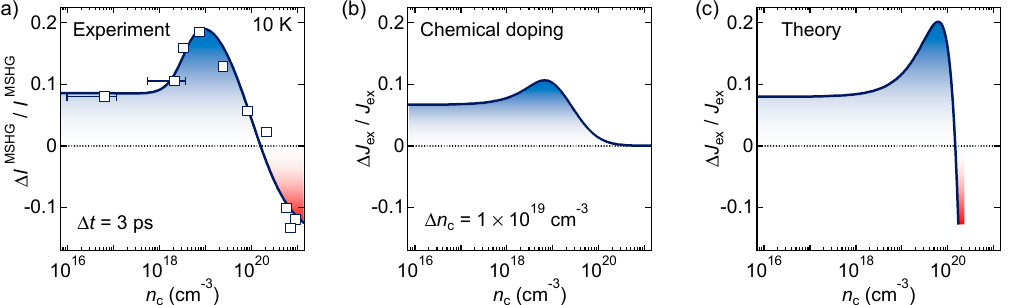
Figure 7. Optical tuning of the exchange interaction J ex in carrier-density-controlled ferromagnetic semiconductor Eu 1 − x Gd x O. ( a ) Relation between n c and the photoinduced change of the MSGH intensity at ∆ t = 3 ps and at 10 K, extracted from the experiments in Figure 6. ( b ) Calculated result of ∆ J ex / J ex by adding a photoinduced carrier density ∆ n c = 1 × 10 19 cm − 3 to the Gd-dependent carrier density n c of the conduction band. Here, ∆ J ex / J ex was calculated using the curve in Figure 3b, assuming that J ex is simply proportional to T C ( ∆ J ex / J ex = ∆ T C / T C ). ( c ) Theoretical calculation of ∆ J ex / J ex based on the modification of the RKKY interaction by the photoinduced non-equilibrium population of the 5 d /6 s conduction band.